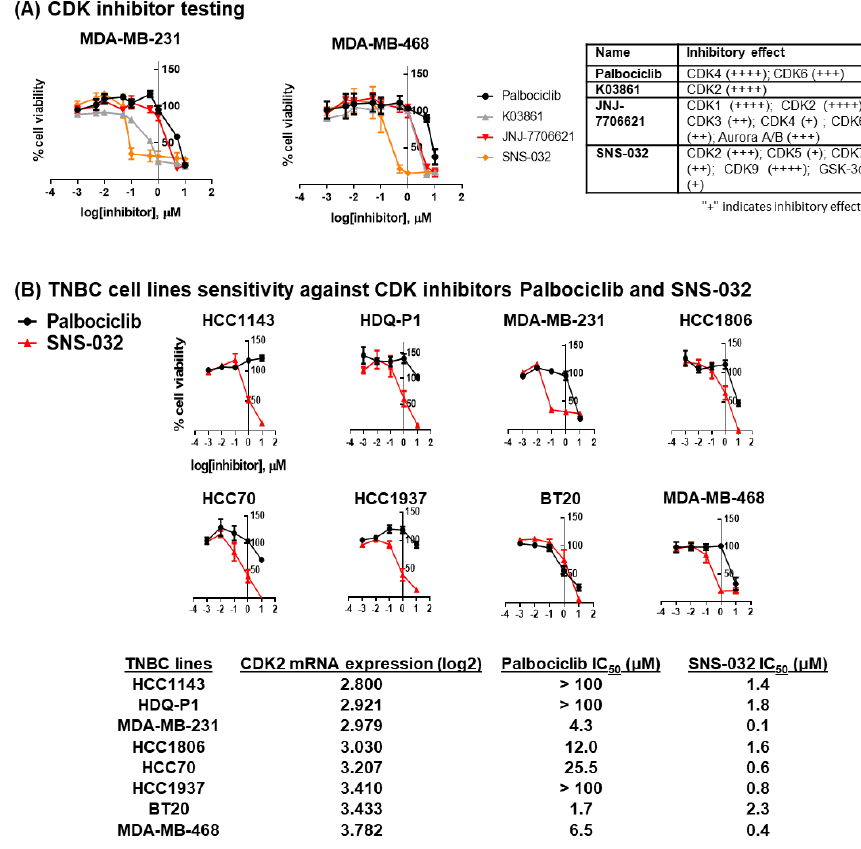
Figure 2. TNBC cell lines are sensitive to CDK inhibitor SNS-032. ( A ) Three small-molecule CDK inhibitors were tested on TNBC cell lines MDA-MB-231 and MDA-MB-468. Cells were treated with a gradient concentration of CDK inhibitors, and cell viability was tested using MTT assay ( n = 3). Inhibitory effects of palbociclib [45], K03861 [40], JNJ-7706621 [41] and SNS-032 [42,43] measured in published cell-free assays are showed in the table, whereas increased inhibition is marked by a higher “+” designation. ( B ) A panel of eight TNBC cell lines were tested against the sensitivity of SNS-032 treatment ( n = 3 for each cell line), compared to CDK4/6 inhibitor palbociclib and IC 50 values were calculated (the Cancer Cell Line Encyclopedia (CCLE) database was used to characterize mRNA expression of CDK2 ). With the exception of BT20, TNBC cells were shown to be more resistant to palbociclib compared to the low half-maximal inhibitory concentration (IC 50 ) for SNS-032 in all cell lines.